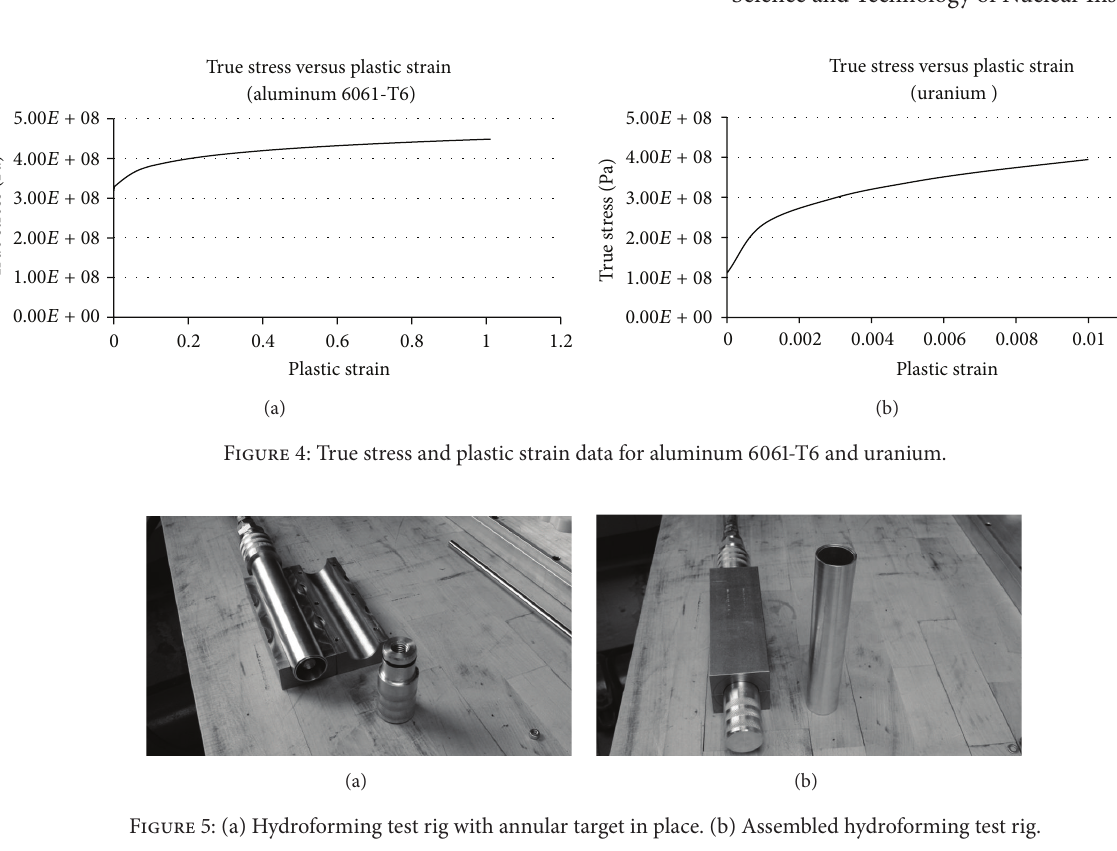
effort required to remove the irradiated foil from the